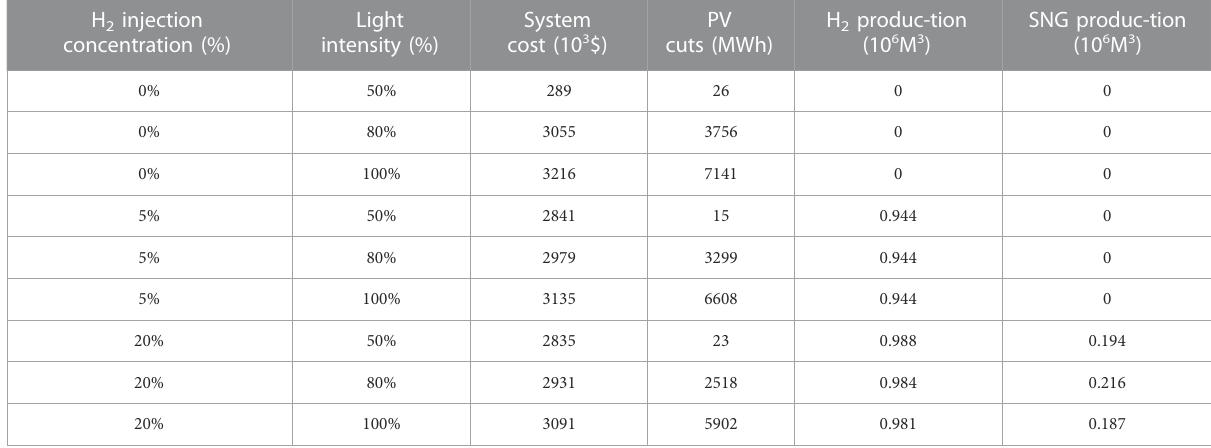
TABLE 1 Operating results of the system under different hydrogen doping concentrations and light intensities. H 2 injection concentration